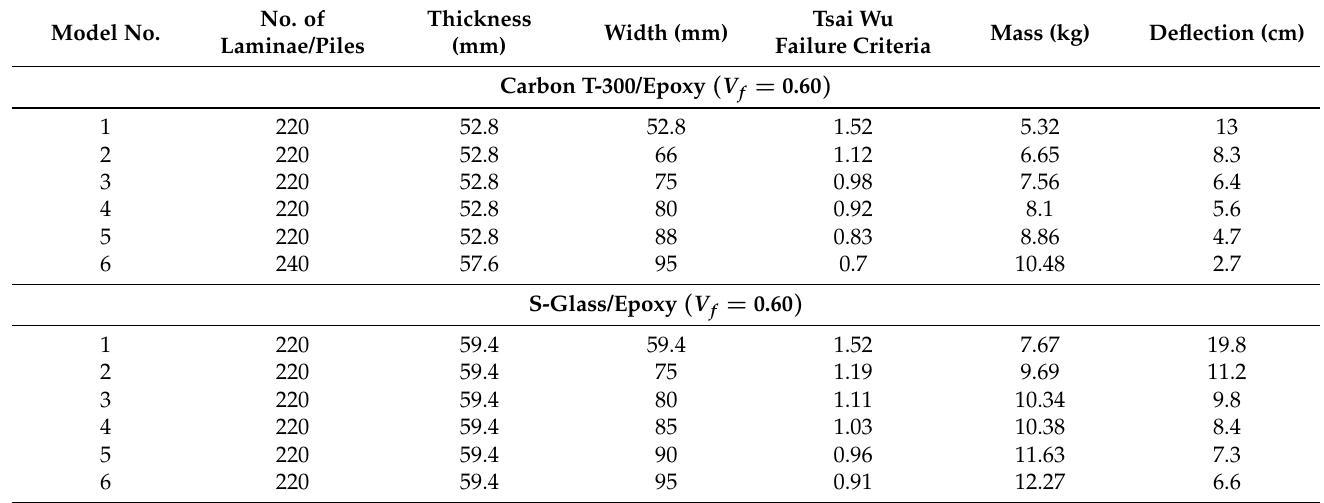
Table 8. Results of computational analysis of composite main landing gear strut without mount- ing brackets.